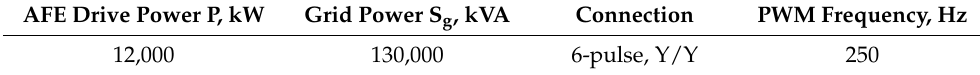
Table 1. Key parameters of the electric drive power circuit. AFE Drive Power P, kW Grid Power S g , kVA Connection PWM Frequency, Hz